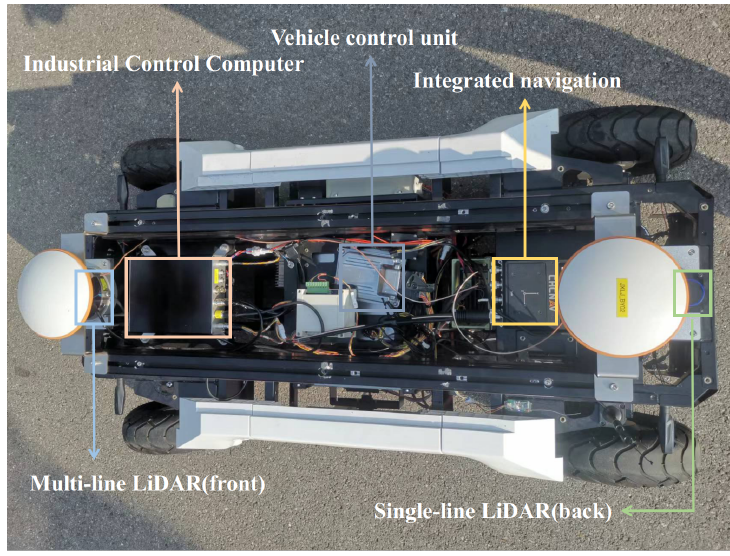
Figure 14. Self-developed autonomous ground vehicle. Table 5. Electronic components.